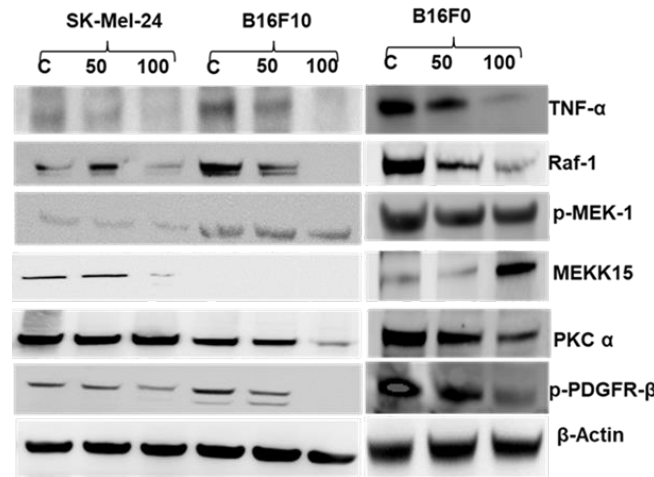
Figure 5. Effects of 2HF treatment on markers of intracellular signaling of mouse and human melanoma cells. Western blot analyses of signaling proteins in B16-F0, B16-F10, and SK-MEL-24 cell lysates in control and 50 or 100 µM 2HF-treated (48 h) experimental groups ( n =